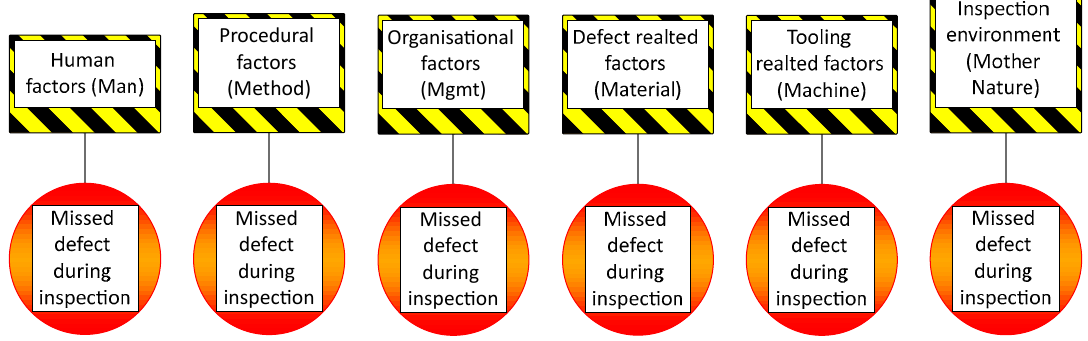
Figure 3. Consistent top event with multiple hazard dimensions.